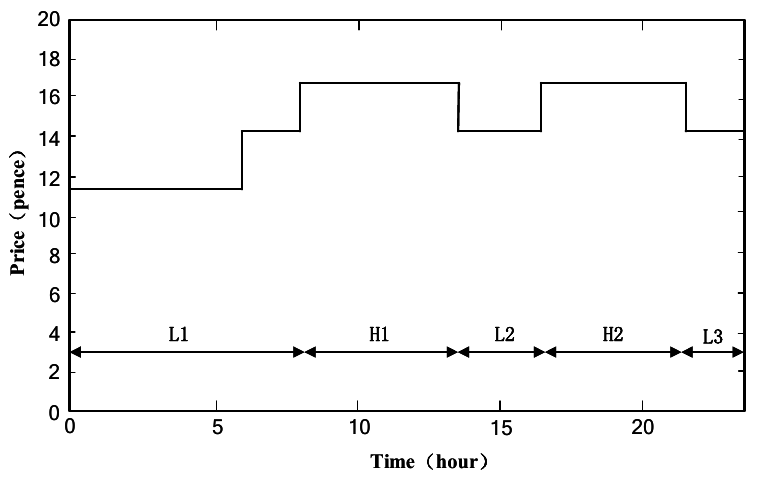
Figure 4. Daily electricity price diagram.